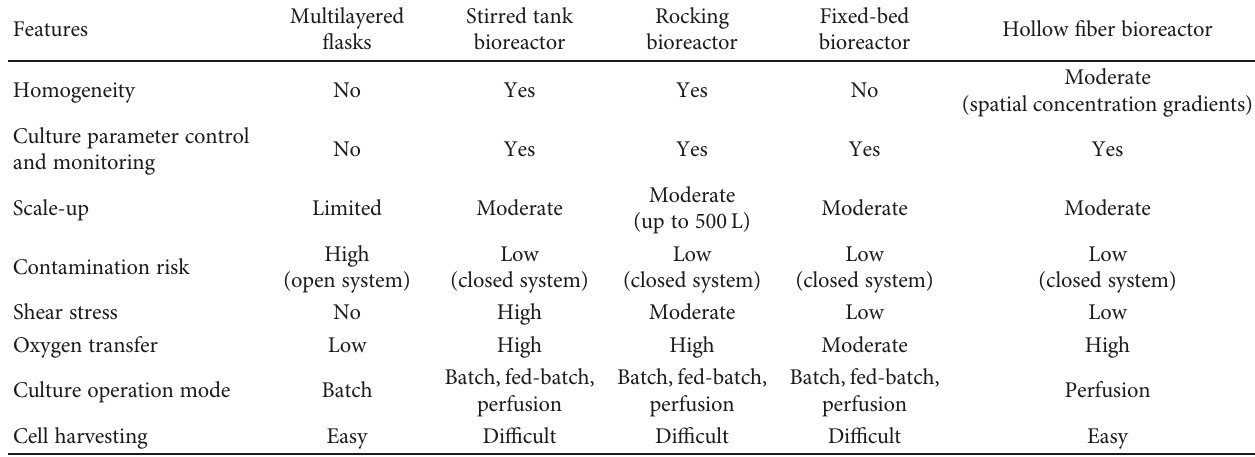
Table 2: Main features of the culture systems and bioreactors employed for MSC